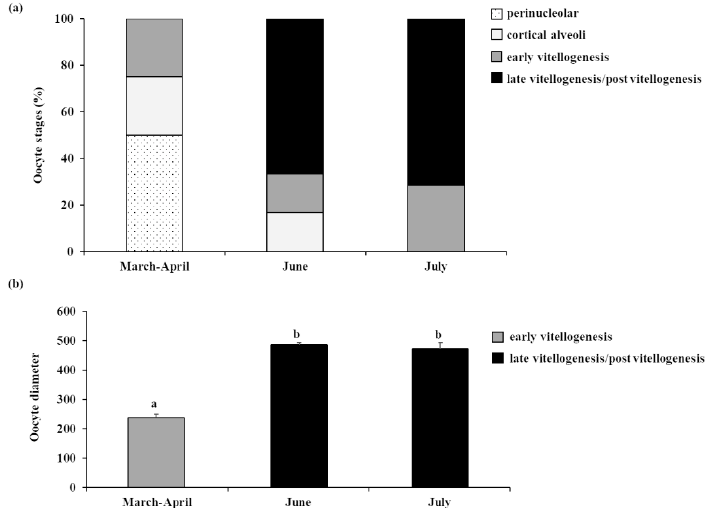
Figure 6. ( a ) Percentage of the different oocyte development stages and ( b ) mean diameter of the most advanced oocyte populations, observed in the ovaries of female meagre reared in floating sea cages. Different letters indicate statistically significant differences between consecutive periods (ANOVA; p < 0.05).